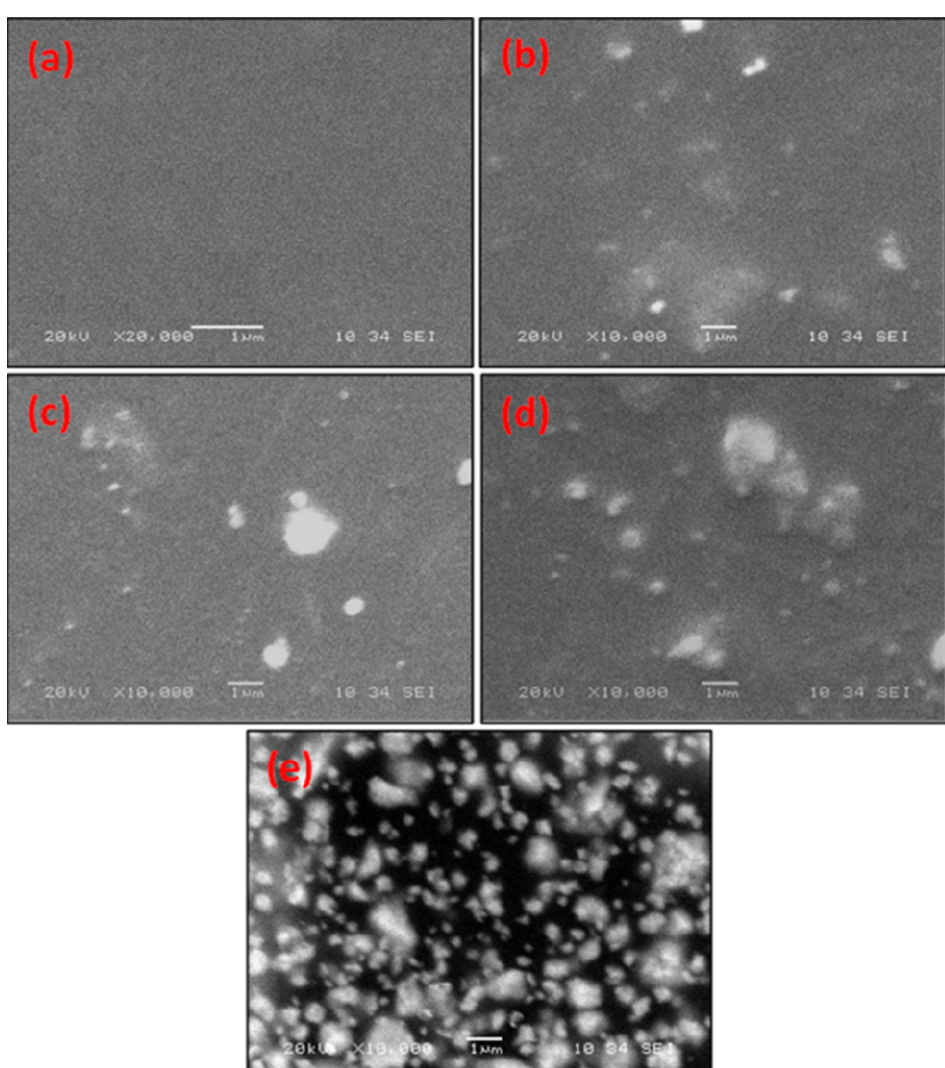
Figure 4. SEM micrographs of the synthesized polymer ( a ) PVA/PVP, ( b ) 1Bi-blend, ( c ) 2Bi-blend, ( d ) 3Bi-blend, and ( e ) 4Bi-blend.